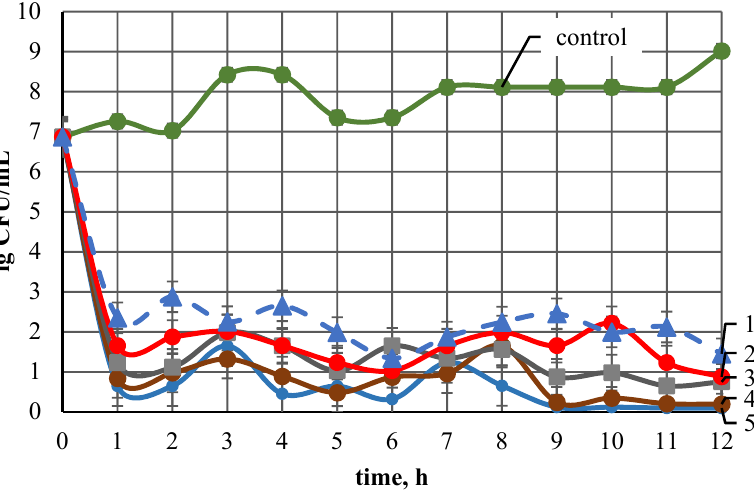
Figure 4. S. epidermidis growth inhibition in presence of: (1) Sample 1-TiO 2 /Ag 14.7 at.% /Cu 13.0 at.% ; (2) Sample 2-TiO 2 /Ag 4.0 at.% /Cu 17.9 at.% ; (3) Sample 3-TiO 2 /Ag 14.3 at.% /Cu 21.3 at.% ; (4) Sample 4-TiO 2 /Ag 18.6 at.% /Cu 22.4 at.% ; (5) Sample 5-TiO 2 /Ag 23.1 at.% /Cu 21.6 at.% ; or in absence of sample—control.